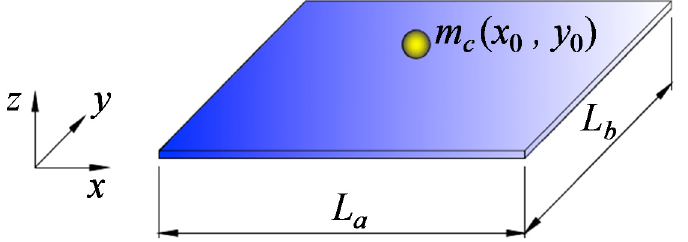
Figure 1. Schematic illustration showing a single-walled GS with an attached